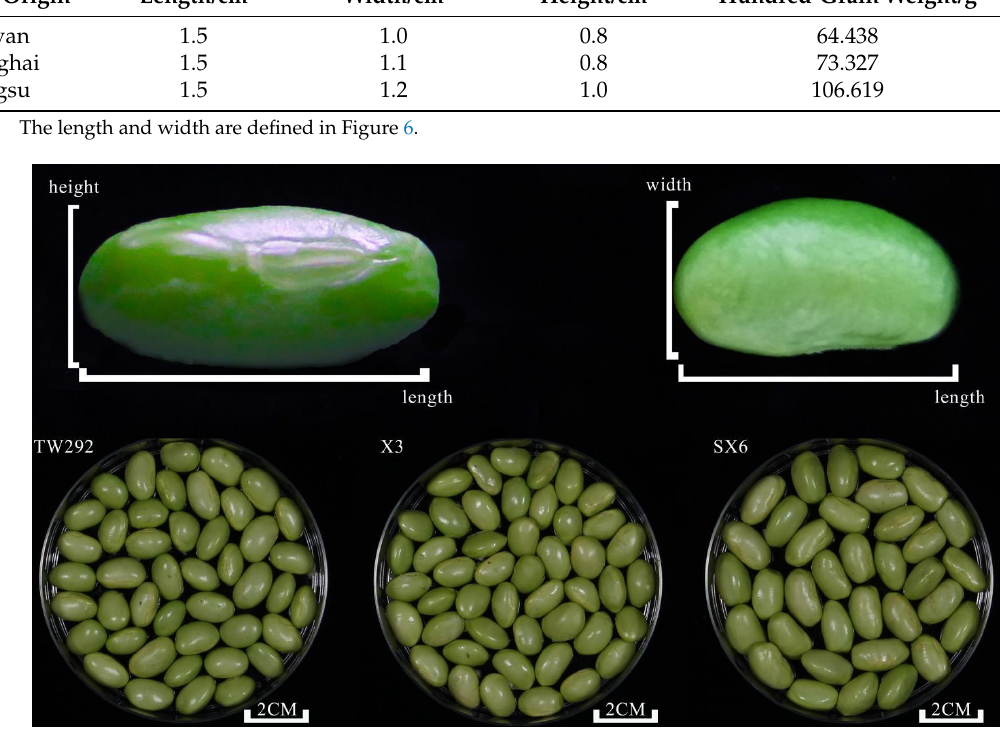
Figure 6. Vegetable soybean samples investigated in this study.